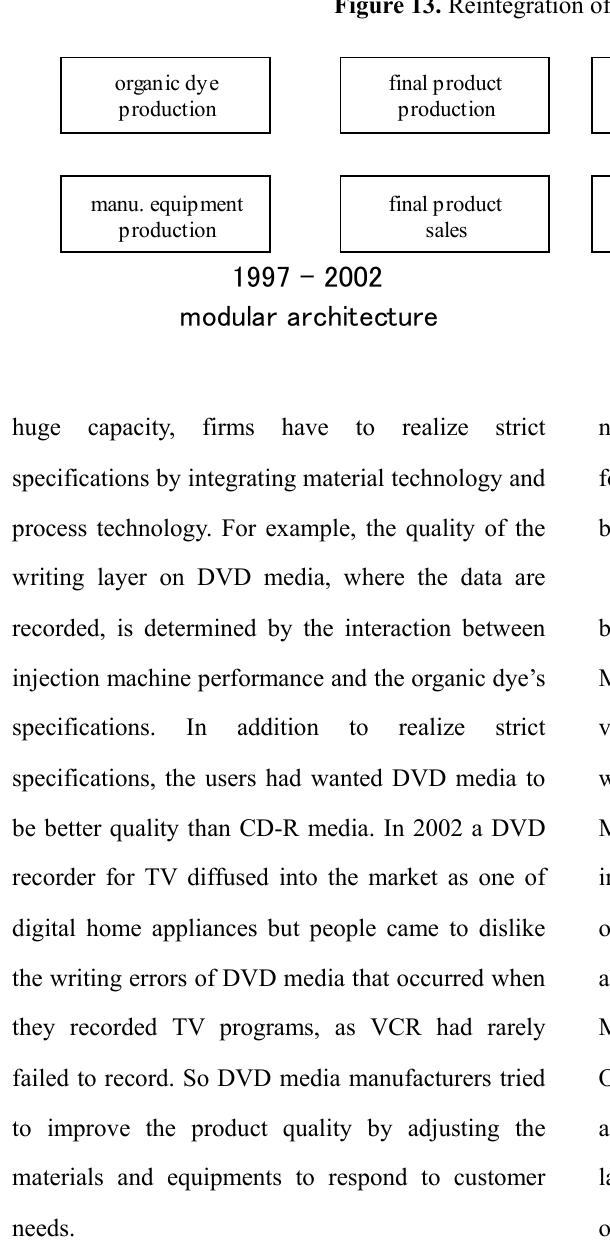
Figure 13. Reintegration of business architecture